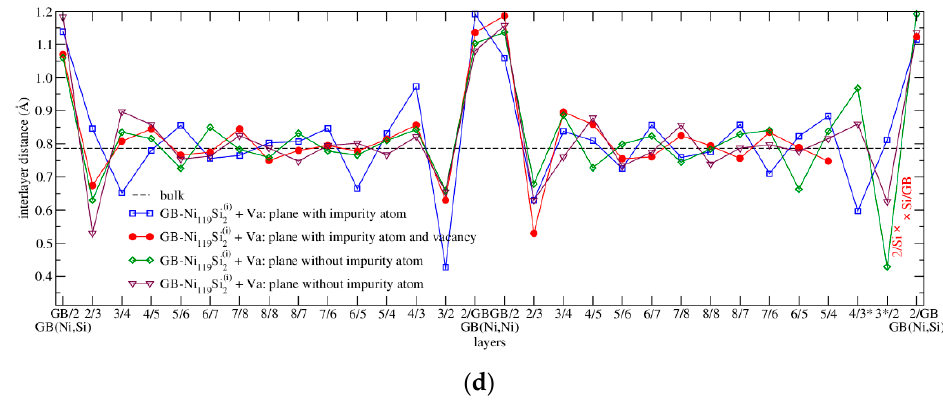
Figure 8. Interlayer distances in supercells with the GB, impurity and vacancy: ( a ) GB-Ni 119 +Va L2 , ( b ) GB-Ni 117 Al 2(s) +Va L2 , ( c ) GB-Ni 117 Si 2(s) +Va L2 , ( d ) GB-Ni 119 Si 2(i) +Va L3 . The superscripts L2 and L3 denote the position of the vacancy in the second and third layer, respectively. × indicates the distances of interstitial Si in the layer with vacancy, which changed its position due to the structure relaxation. * denotes the layer with the vacancy. The dashed line corresponds to the interlayer distance in ferromagnetic fcc Ni (this work). The lines do not reflect any physical meaning; they are used to guide the eye only. For a better demonstration of results in the cases of Figures (b–d), the plane with impurity atom is always presented so that the impurity is on the edges of the figures. This was achieved by the shift of ½ of the lattice parameter b of lines representing the results of some planes with impurities (the middle plane of GB-Ni 118 Al 2(s) and GB-Ni 118 Si 2(s) or the second plane of GB-Ni 120 Si 2(i) ) and one without impurity (the middle plane of GB-Ni 120 Si 2(i) ).